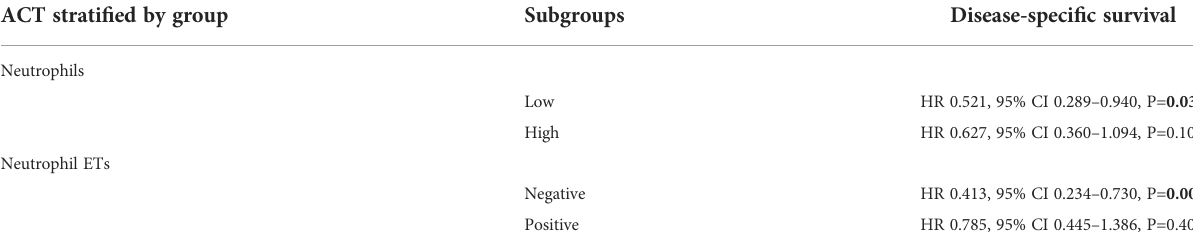
ACT, adjuvant chemotherapy; ET, extracellular trap; HR, hazard ratio; CI, con fi dence interval. P values <0.05 are